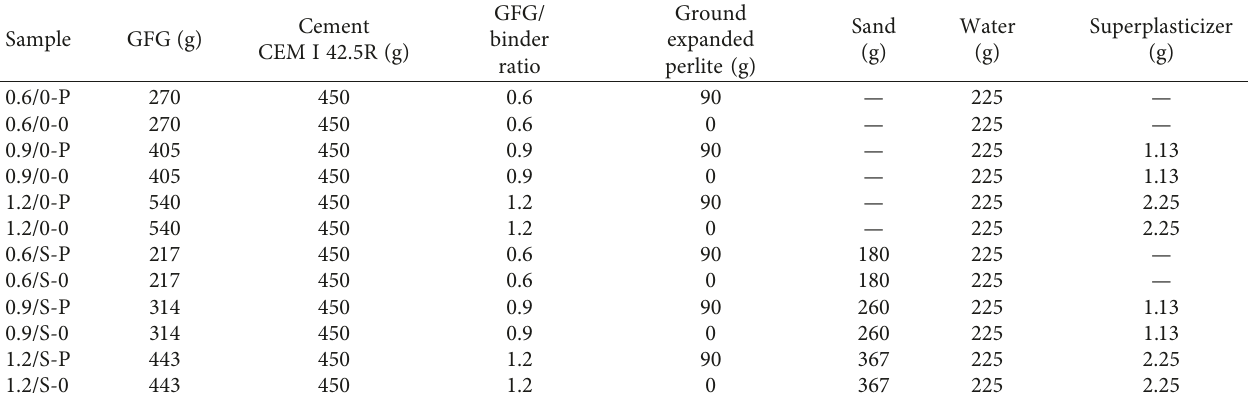
Table 2: Composition of mortars.